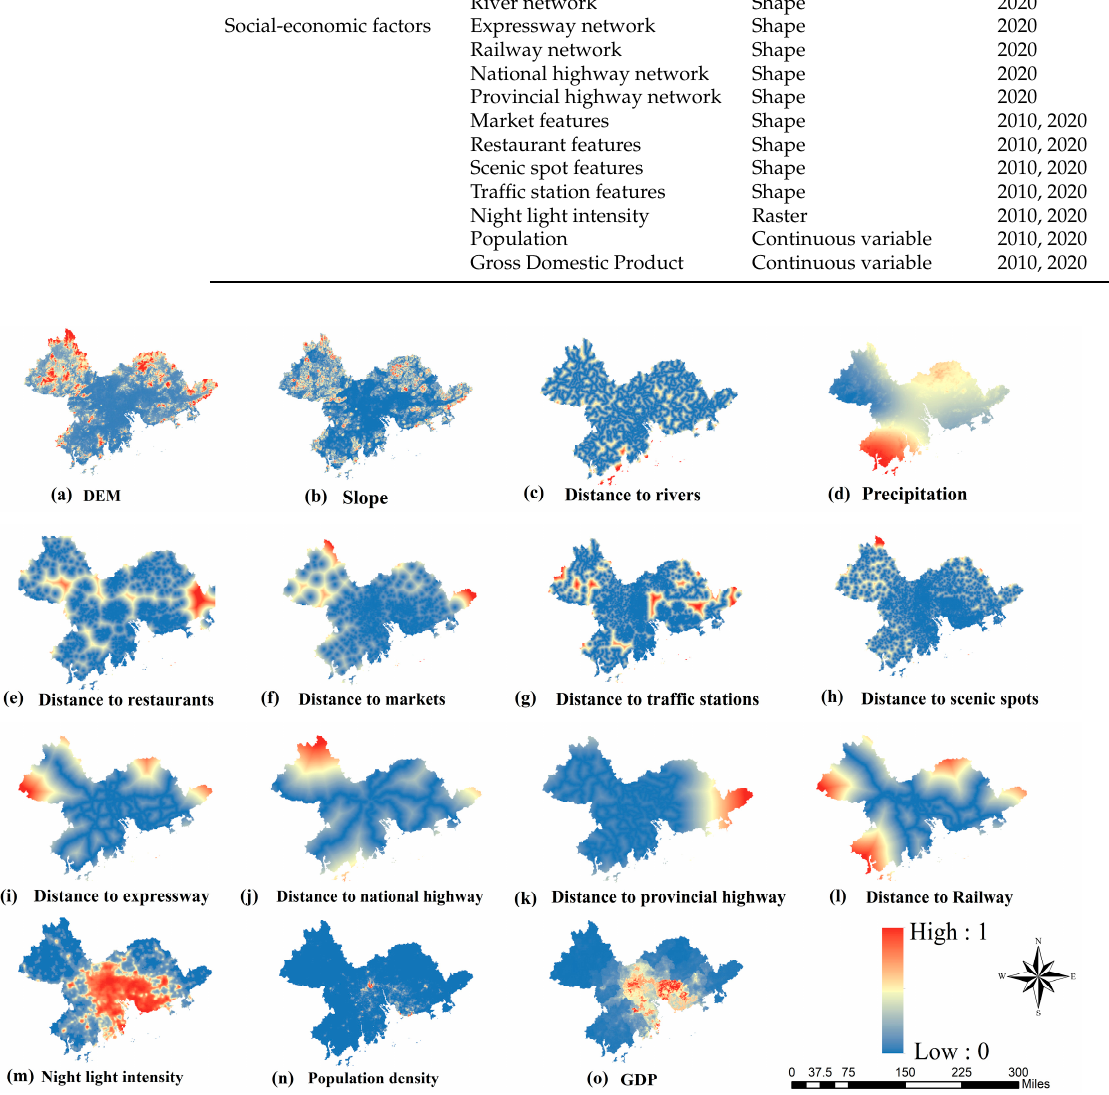
Figure 2. Spatial variables in Pearl River Delta. Figures ( a – d ) show the natural factors. Figures ( e – o ) show the social and economic factors (All the data were normalized).